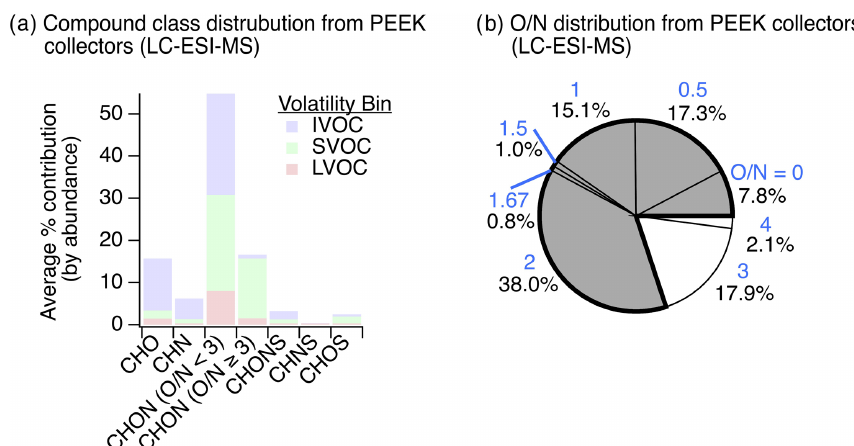
Figure 5. Observations of gas-phase nitrogen-containing compounds. (a) The distribution of functionalized gases observed via sampling on PEEK collectors ( N = 6) and inline mobile phase desorption with non-targeted LC-ESI-MS analysis contained a diversity of oxygen-, nitrogen-, and/or sulfur-containing compounds in the IVOC–LVOC range (volatility assignment and grouping were the same as discussed in Fig. 2 at a reference temperature of 300K for intercomparison). While we cannot rule out gas-phase LVOC contributions from evaporation off of the upstream particle filter, LVOC contributions were limited ( ∼ 12%). (b) Oxygen-to-nitrogen (O / N) ratio distribution of observed gas-phase nitrogen-containing species where O / N ratios < 3 are colored grey and O / N ratios ≥ 3 are colored white (blue text above each percentage signifies the O / N ratio). The same data, tallied by occurrence, are shown in Fig. S9 for